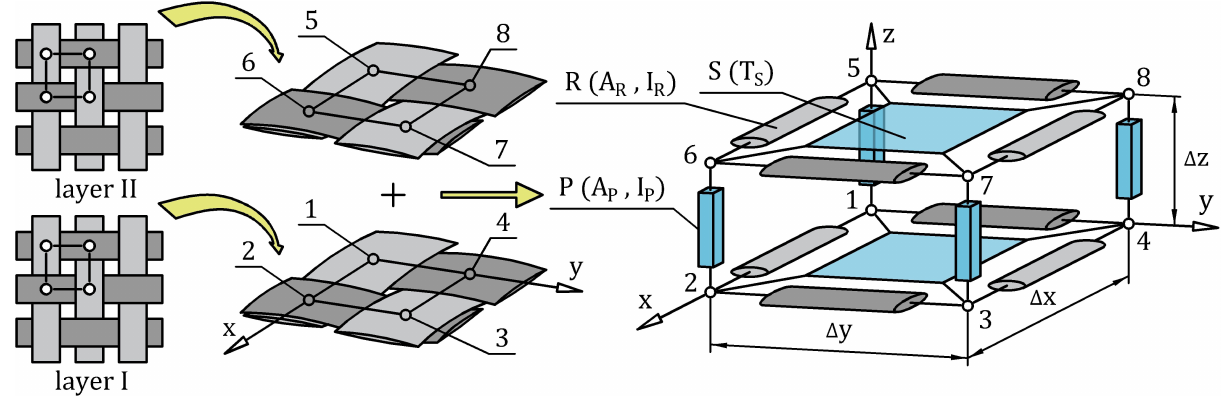
Figure 2: Mesoscale model of two joined